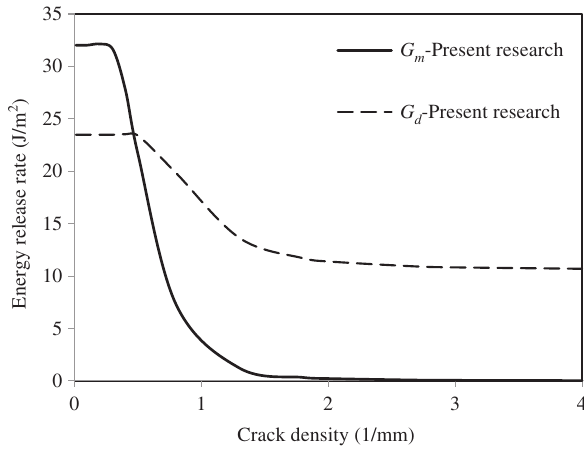
] s carbon/ 3 = 10 2